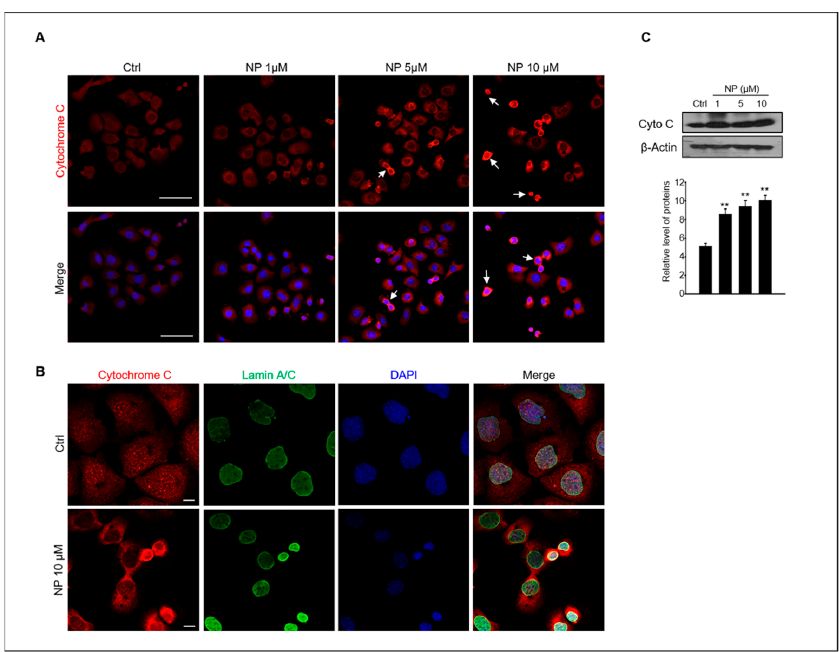
Figure 3. NP induces cytochrome c release in GC-1 spg cells. ( A ) GC-1 spg cells were treated with 0, 1, 5, and 10 μ M NP for 24 h and then labeled with a cytochrome c (red, white arrow) antibody and co-labeled with DAPI to visualize cell nuclei with confocal microscopy. Scale bar, 50 μ m. ( B ) labeled with a cytochrome c antibody and co-labeled with Lamin A/C to visualize the nuclear en- velope. Scale bar, 10 μ m. ( C ) Western blot of cytochrome c in GC-1 spg cells treated with 0, 1, 5, and 10 μ M NP for 24 h. The density of cytochrome c bands was normalized to that of β -actin. Data are shown as the mean ± SD of three independent experiments ( n = 3, * p < 0.05 and ** p < 0.01 com- pared to the controls).